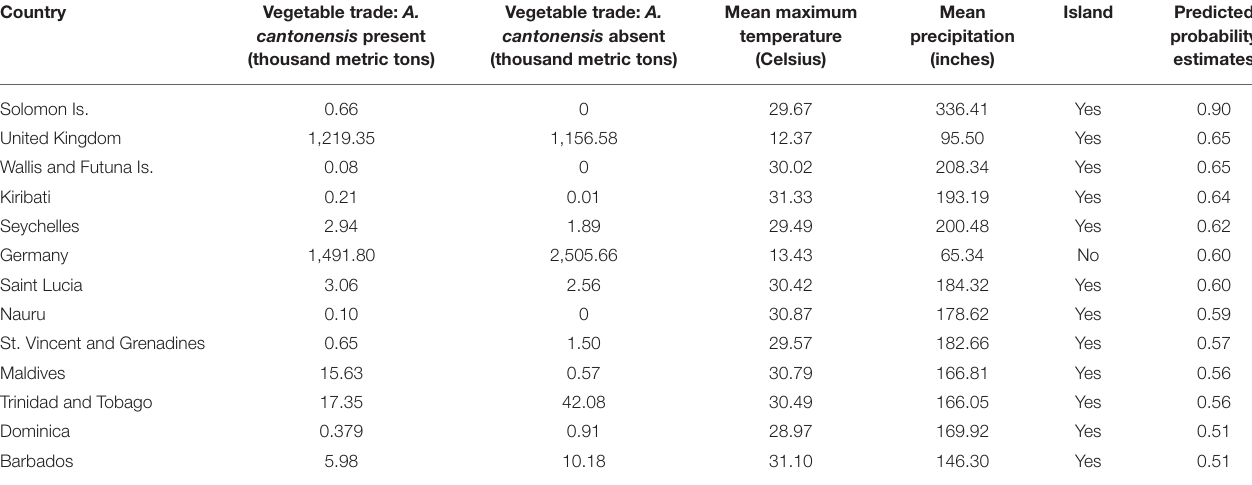
Absolute values of trade and climatic variables are shown and represent the average annual values. Vegetable trade is grouped by A. cantonensis status of exporting country (present and absent).